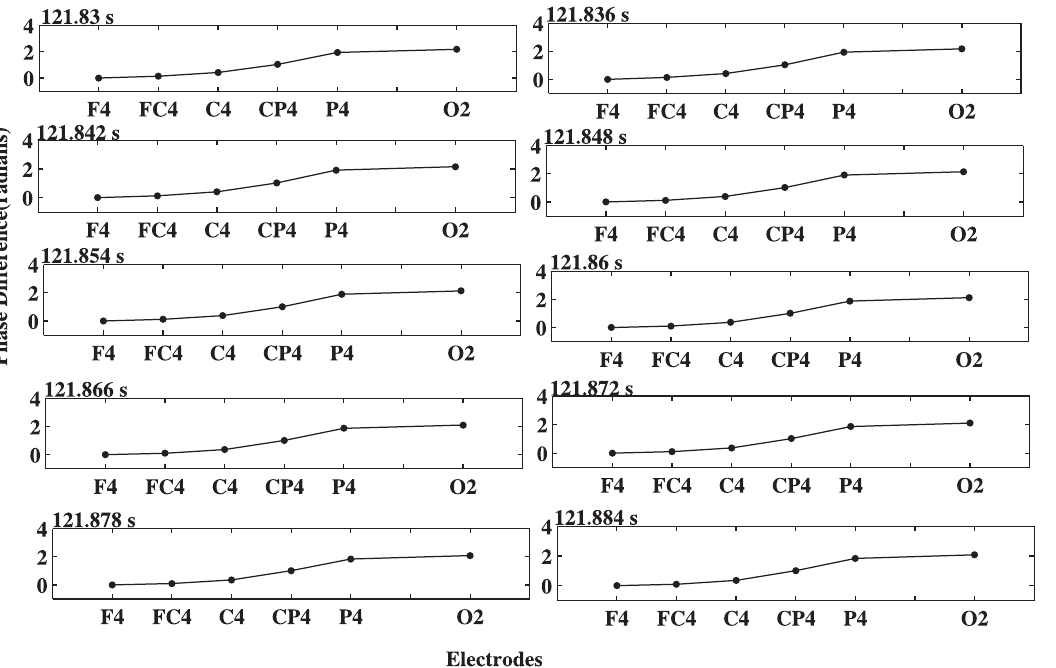
Figure 4. Phase differences along the chain of electrodes, including F4, FC4, C4, CP4, P4, and O2, at different times with step size of 6